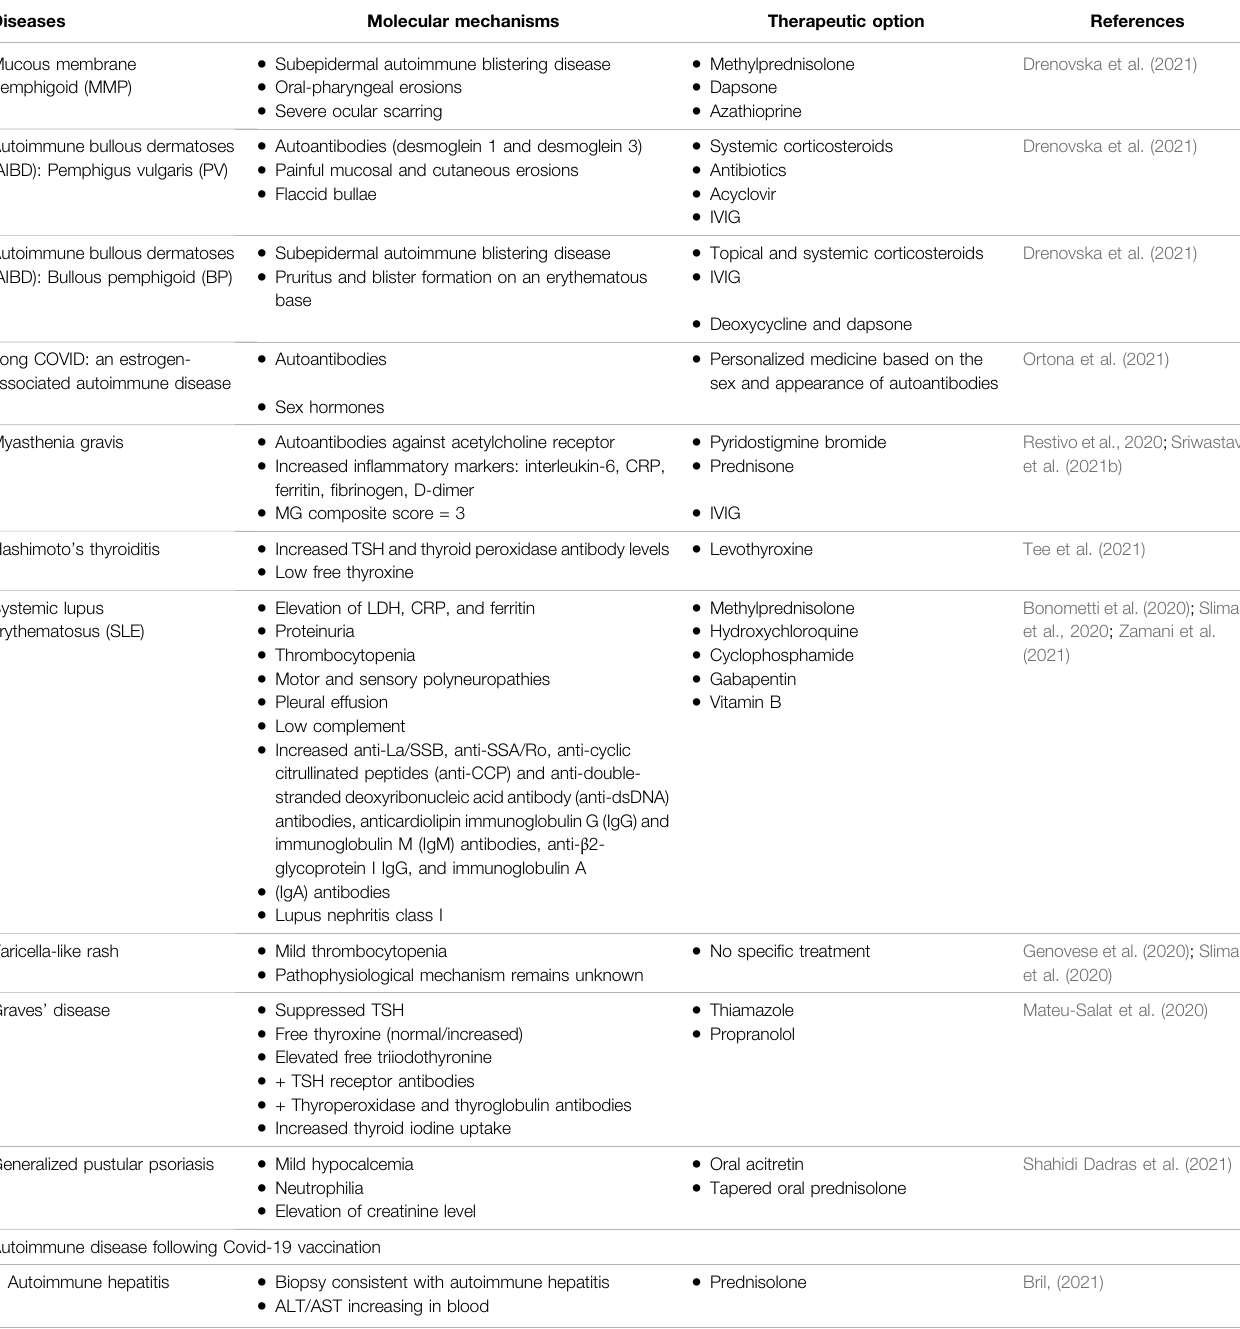
TABLE 2 | Summary of molecular mechanisms of and therapeutic options for autoimmune diseases following SARS-CoV2